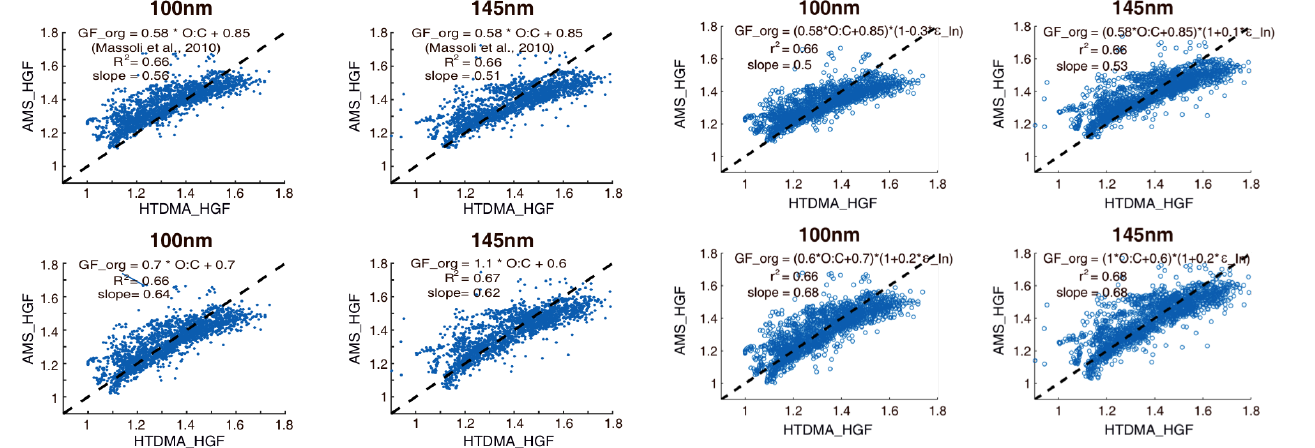
Figure 6. Comparison between AMS-derived HGF with measured HGF when taking into account the influence of oxidation level of the organics on GF, with upper panels using the relation determined by Massoli et al. (2010), and lower panels by fitting the equation GF = a × O : C + b into our data. The dashed lines indicate the 1 : 1 lines.